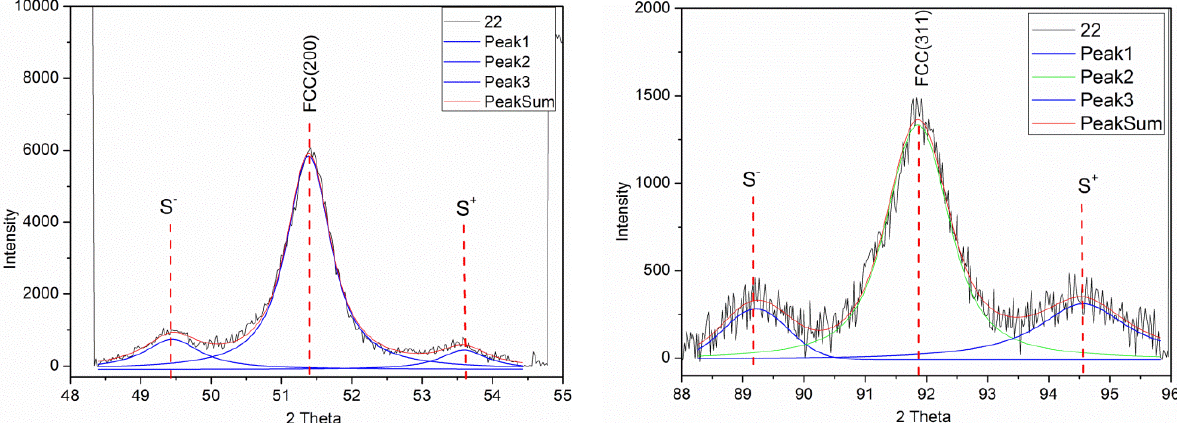
Figure 1. XRD pattern (black line) around the main fcc(111) reflection for the Ni-Co/Cu multilayers with t Cu = 1 nm (sample 17, left panel ) and t Cu = 5.0 nm (sample 11, right panel ) spacer layers. The green line represents the fit for the main reflection (peak 2), and the blue lines represent the fits for the lower-angle satellite peak S − (peak 1) and the higher-angle satellite peak S + (peak 2). The red line is the sum of the three fitted peaks. From the satellite peak positions the bilayer length was is much smaller than the experimental Λ XRD / Λ nom ratios, and affects the observed trend obtained as  Λ XRD = 4.0 nm for sample 17 ( Λ nom = 3.0 nm) and Λ XRD = 8.0 nm for sample 11 ( Λ nom = to a negligible extent only. 7.0 nm).